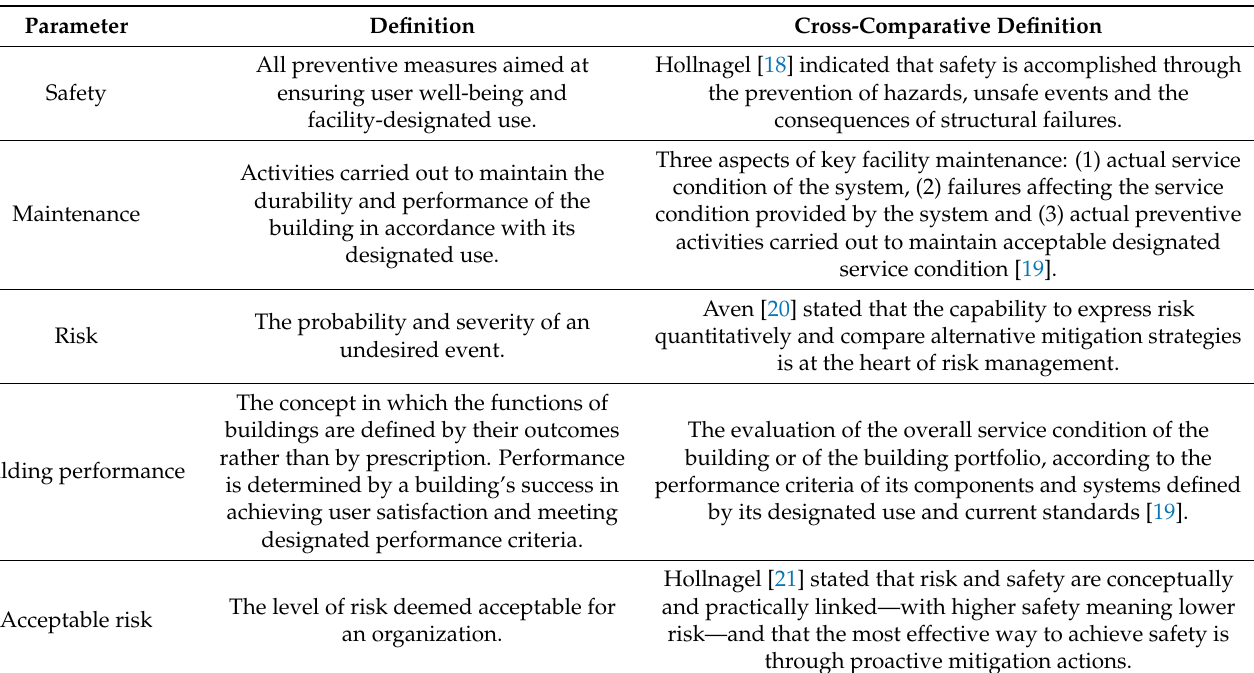
Table 1. Cross-comparative definitions of the core variables of the